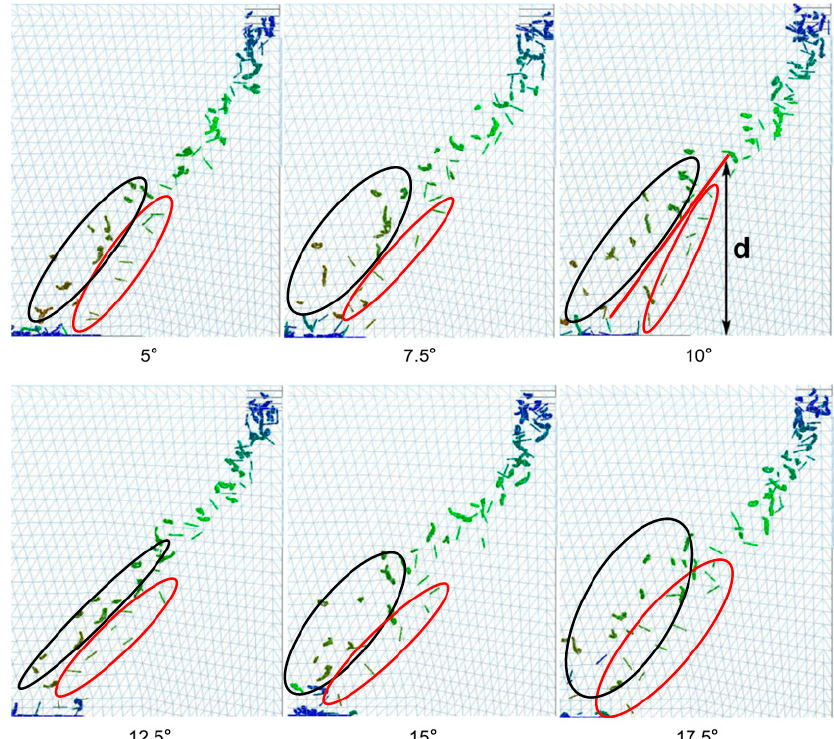
Figure 16. Tea material distributions for different wind directions, where d is stratification height. Black oval is tea distribution area, and red oval is distribution area of tea stems.